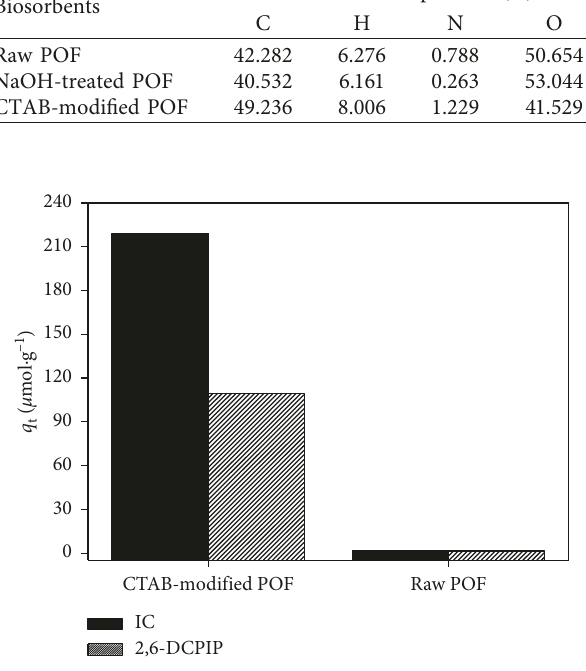
Figure 5: Effect of CTAB-modified POF on the IC and 2,6-DCPIP